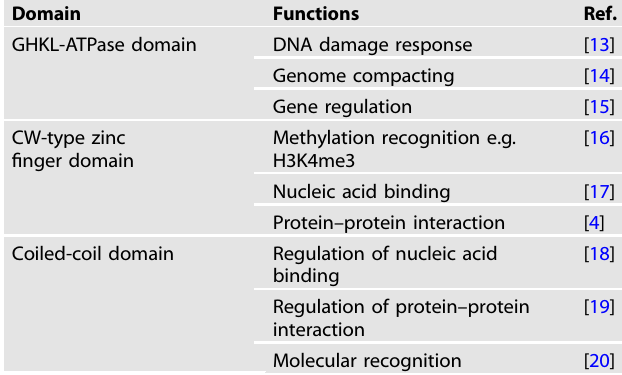
Fig. 1 The arrangement of the domains of human MORC family. According to given evidence and Pfam analysis results, the domain structures in human MORC protein have been de fi ned with three hallmarks: a conserved GHKL-ATPase domain at N-terminal, a conserved CW-type zinc fi nger domain in the middle and several coiled-coil domains. In addition, MORC proteins in eukaryotes contain a structure similar to that of the second domain of ribosomal S5 proteins (hence named the MORC-S5 domain). Aside from these common structural determinants, human MORCs also exhibit unique structural motifs, such as nuclear matrix binding and RNA bindings, which are particularly apparent in MORC3. Table 1. Domain architectures and biological functions of MORC